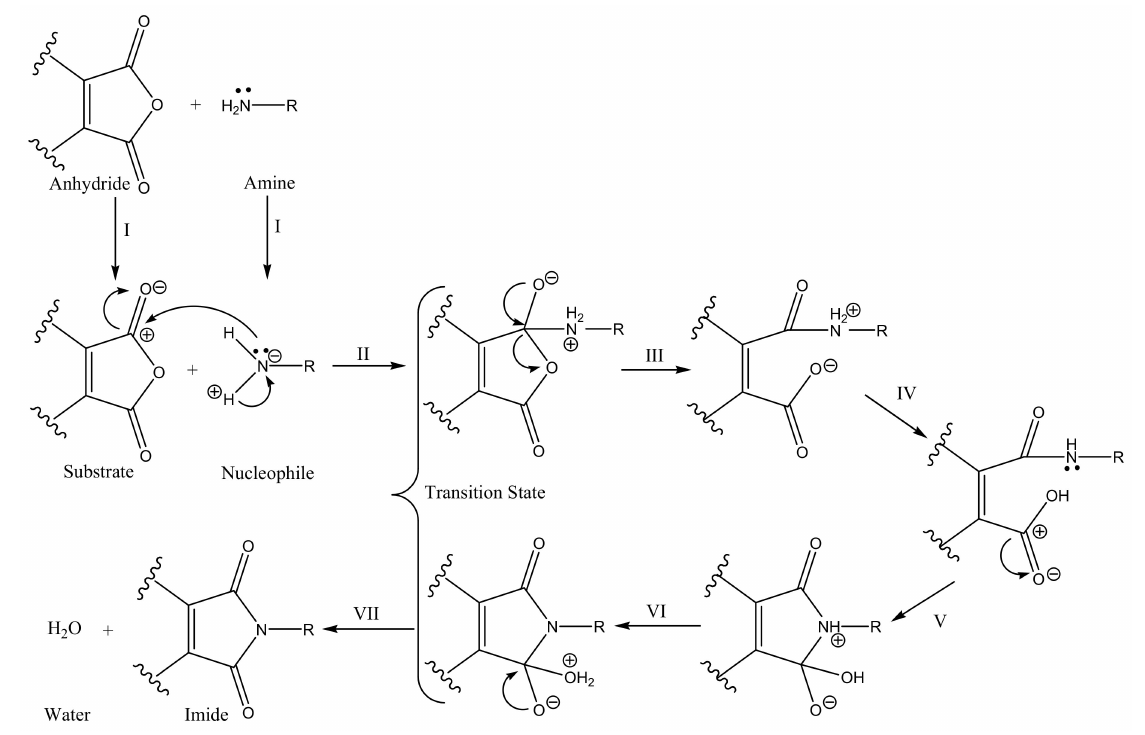
Figure 3. The proposed steps of the reaction mechanism. Table 2. Human CAs inhibition data [30], selectivity ratios and docking scores of sulphonamides 1–13 and other clinically used